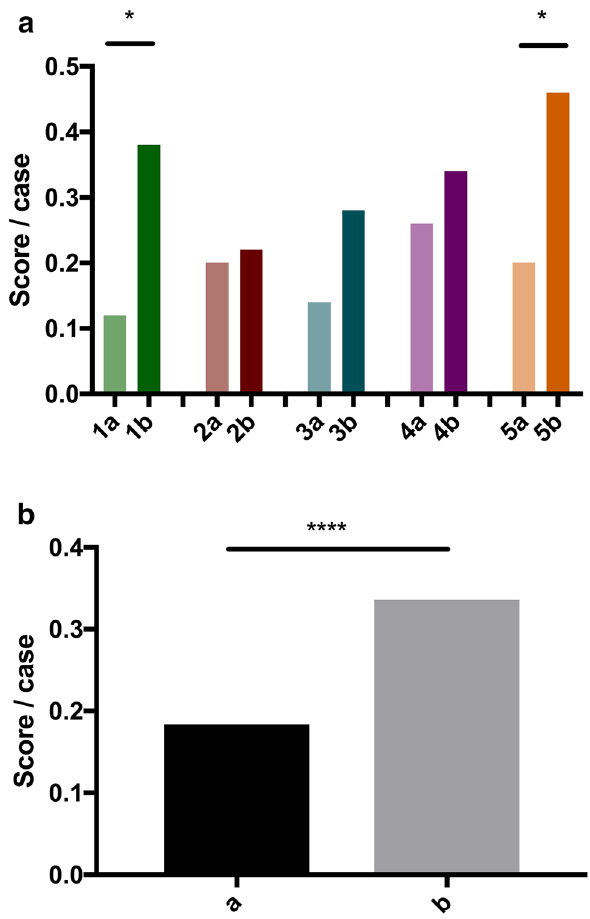
Figure 3. ( a ) Mean score per case of each resident 1–5 without SPS (a) and with SPS (b). ( b ) Mean score/case without SPS (a) and with SPS